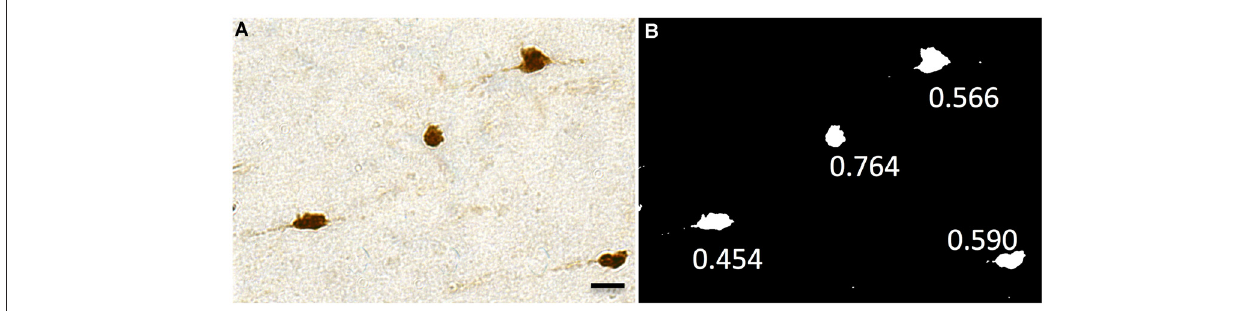
FIGURE 7 | Representative images showing circularity of neurons . This ranges from 0 (a flat line) to 1 (a perfect circle). (A) Neu-N labeled WMNs. (B) These are thresholded and binarized, and circularity is measured with ImageJ. Scale bar = 20 µ m.